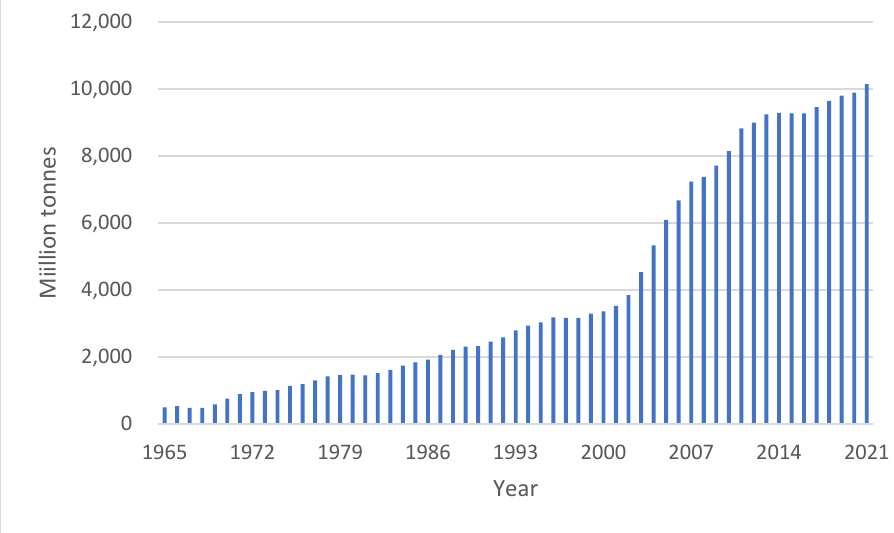
Figure 1. Carbon dioxide emissions in China.